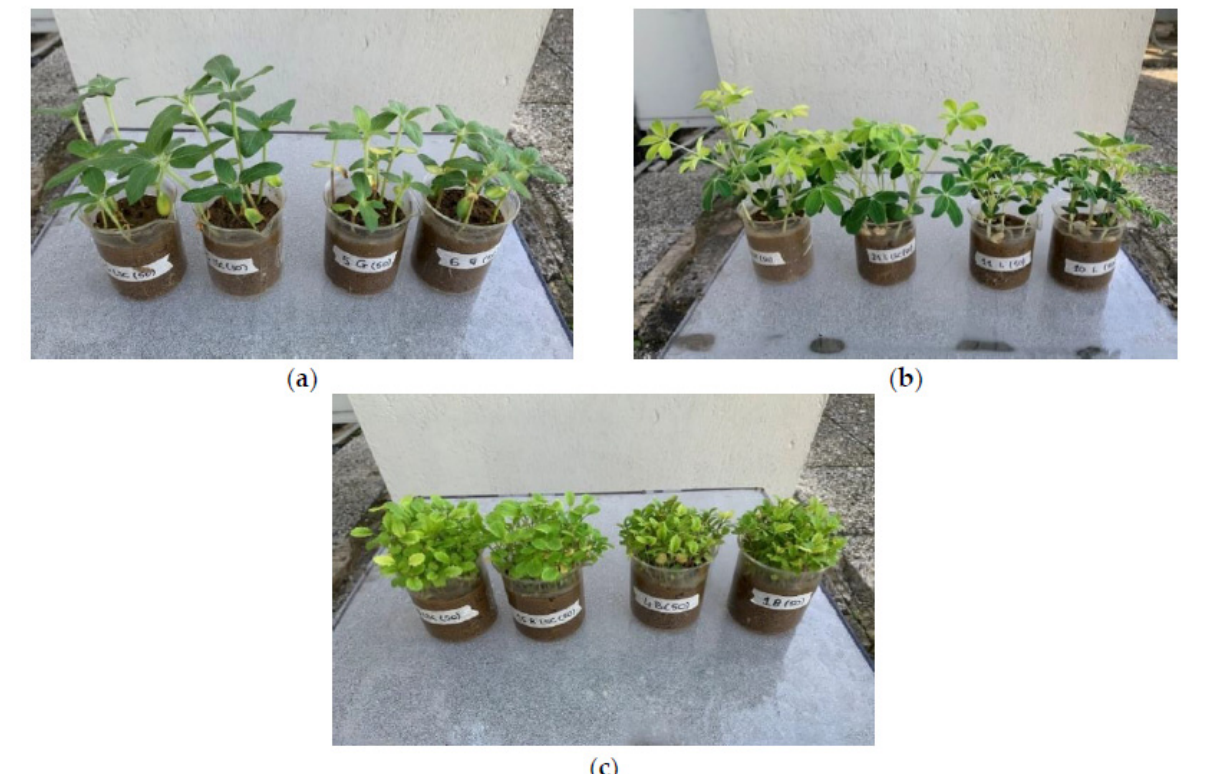
Figure 10. A picture of plants grown under the two different boxes, ( a ) L. albus , ( b ) H. annuus, and ( c ) B. juncea . On the left of the beholder, the plants grown under the LSC box.